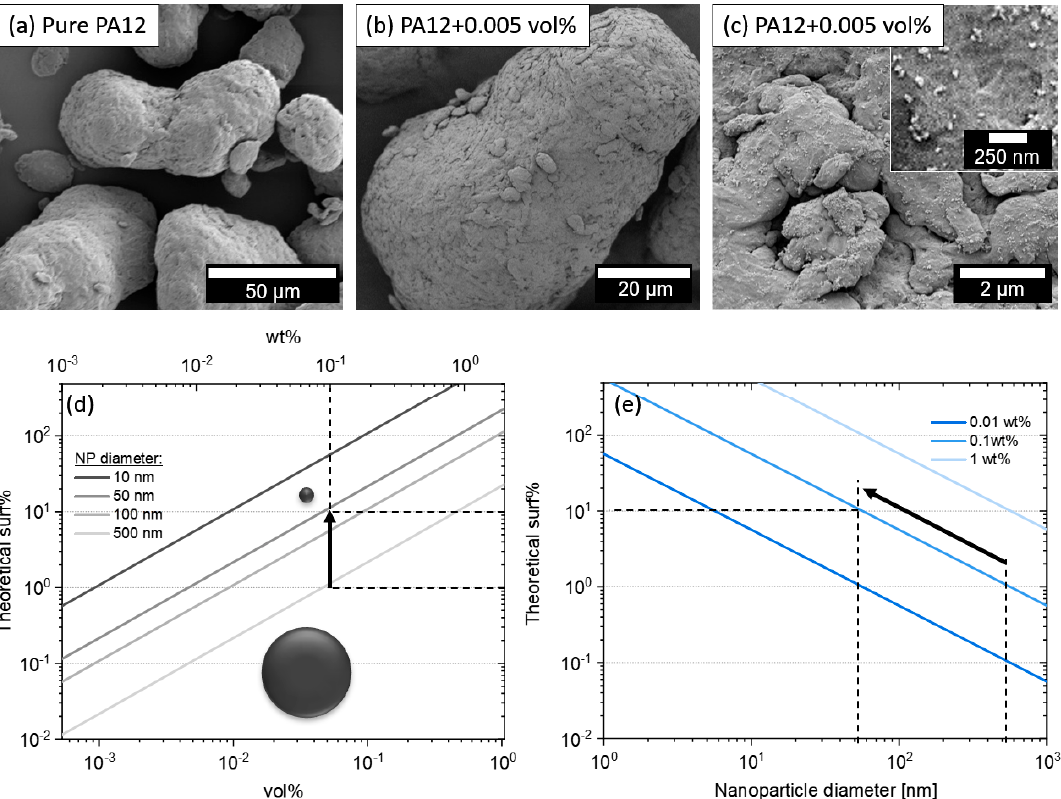
Figure 6. ( a ) SEM images of PA12 particles ( a ) before and ( b ) after colloidal additivation with 0.005 vol% (0.01 wt%) of carbon nanoparticles (LPP at highest fluence). ( c ) Zoom in shows the homogeneous distribution of carbon nanoparticles on the surface of the polymer microparticle. ( d , e ) Scaling graphs illustrating the connection between vol%, wt%, and surface coverage (surf%) for di ff erent nanoparticles sizes on PA12 polymer powder (The specific surface area of PA12 was 0.114 m 2 / g, calculated from the particle size distribution, assuming spherical particles.). The dotted lines give an example of downsizing of the nanoparticle diameter and its e ff ect on the theoretical surface coverage.